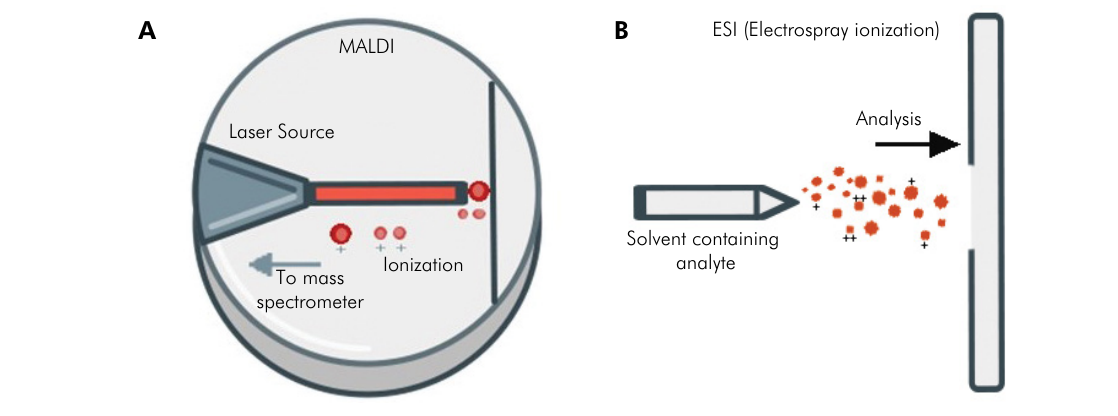
Figure 1. A: Ionization methods - MALDI: the peptides are crystallizing into an organic matrix and are ionization by laser; B: Ionization methods - ESI: The aqueous solution containing the analyte is forced through a capillary needle which upon evaporation of the solute generates ionized